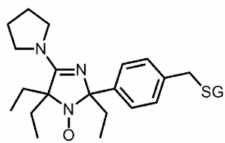
Figure 10. A typical dual pH-redox nitroxide probe for investigation of the tumor microenvironment. Covalent linkage to a charged glutathione moiety (-SG group in the structure) ensures extracellular localization and prevents diffusion through cell